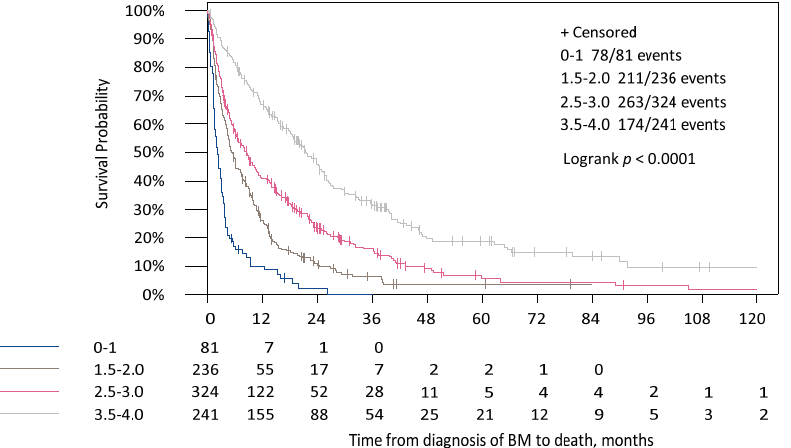
Figure 2. Survival times for the time from diagnosis of BM to death in the four categories of the Breast-GPA Score. In the updated Breast-GPA median survival times variated between 2.7, 5.2, 15.2 and 32.2 months for the four categories (Table 4, Figure 3). All in all, 12.9% of the patients were contributed to the worst prognostic group ( n = 114) and only 10.1% in the best prognostic group ( n = 89). All categories defined by all three scores were associated with survival in univariate analysis ( p < 0.001 for all scores, Table 4). Figure 3. Survival times for the time from diagnosis of BM to death in the four categories of the updated Breast-GPA Score. 2.4. Diagnostic Accuracy of GPA Scores When looking at time-dependent specificities identifying patients with a long-life ex- pectancy (>12 months) the highest category of each score was compared with the lower three categories (Table 5). The Breast-GPA had the highest value of specificity with 68.7% in comparison to the updated Breast-GPA with 48.1% and the original GPA with 21.8%. The time-dependent NPV (the probability of living longer than 12 months with a high Logrank p < 0.0001